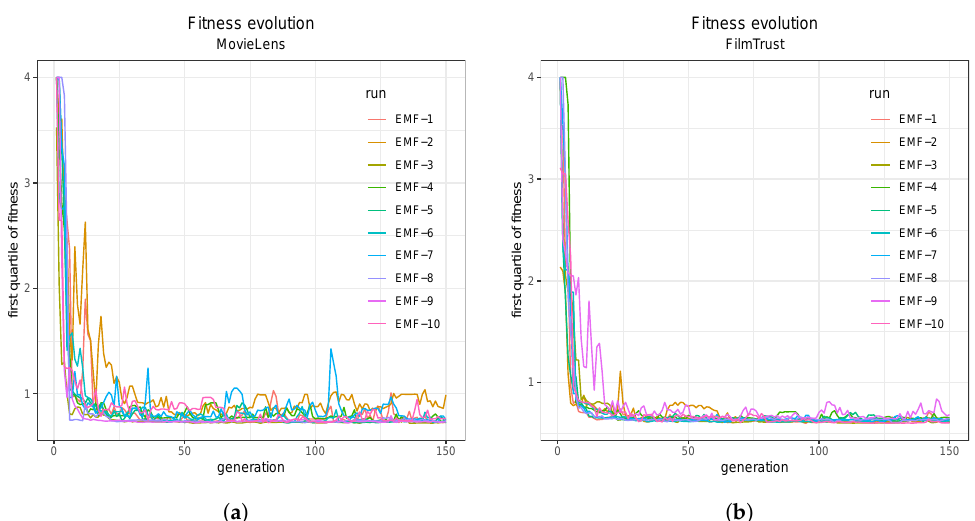
Figure 4. Evolution of the 25th percentile (first quartile) of the population fitness for each run on both ( a ) MovieLens and ( b ) FilmTrust